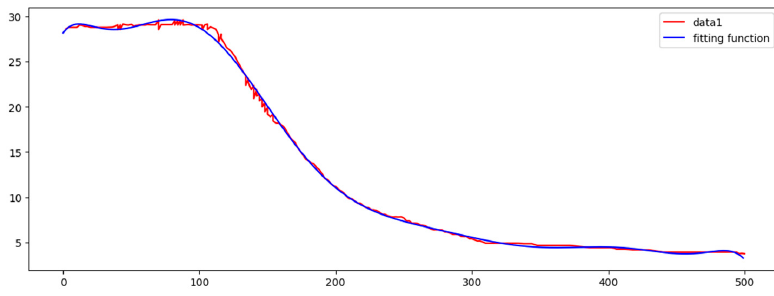
Figure 14. Marine data curve and the fitting function curve.